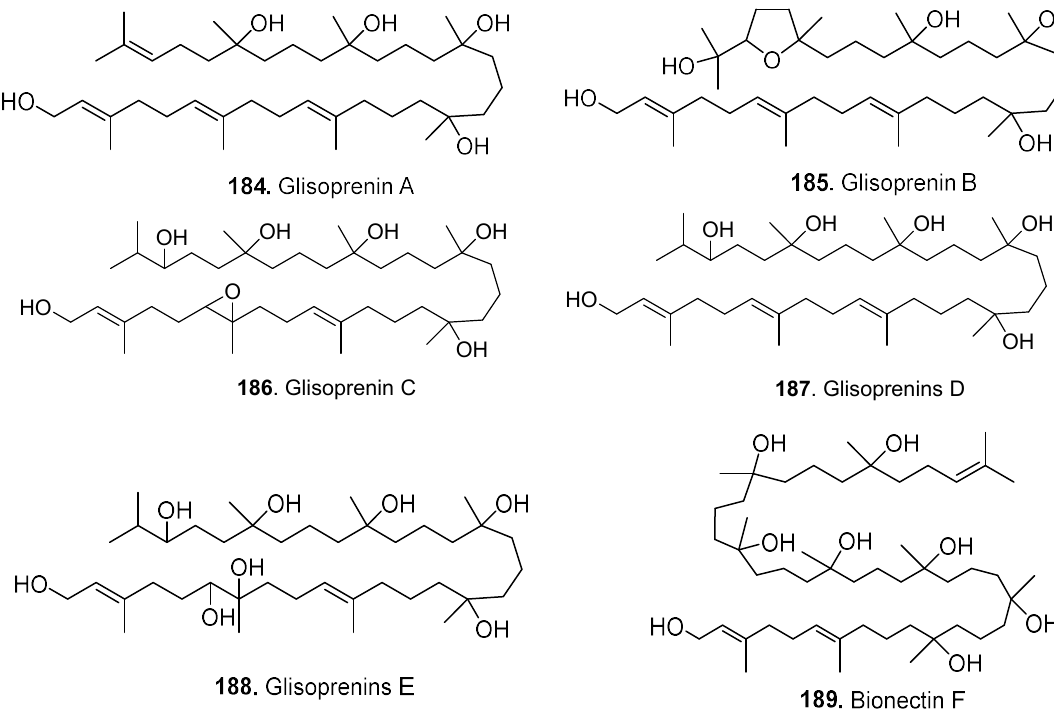
Figure 13. Polyterpenoids isolated from Clonostachys fungi.